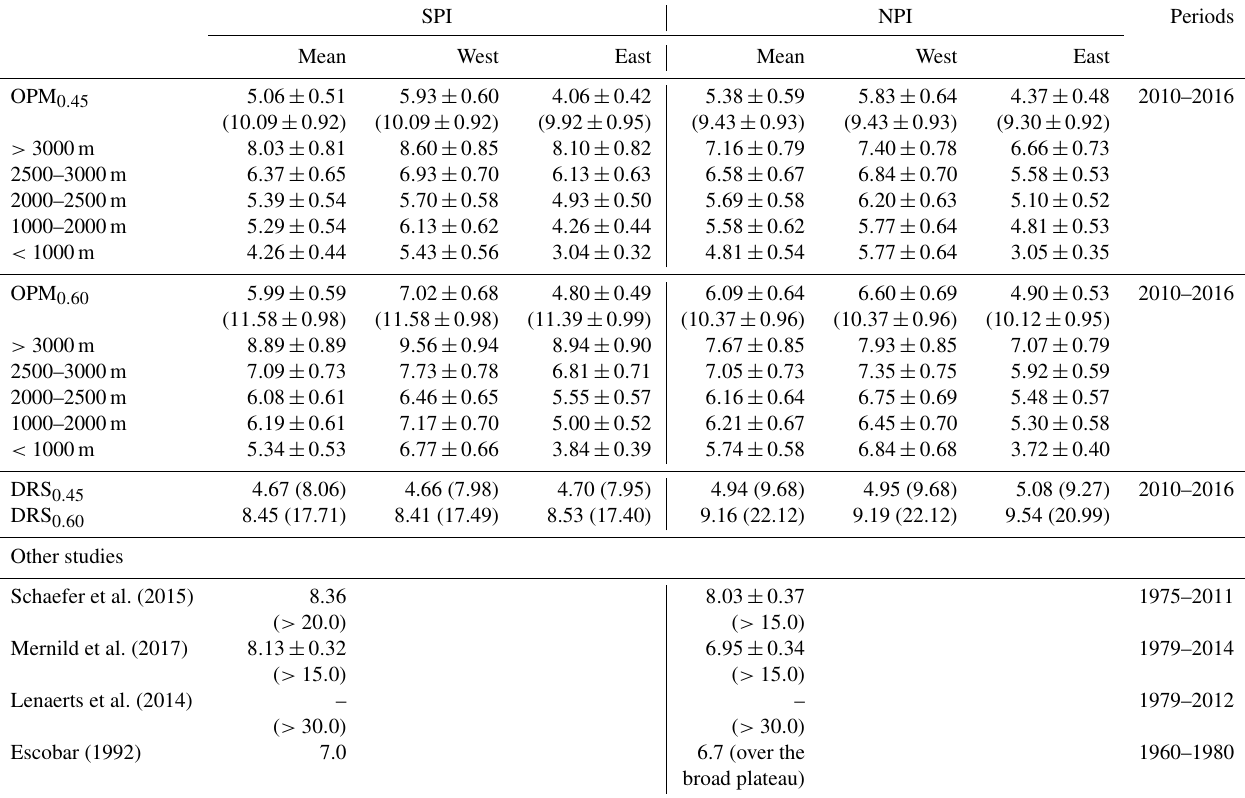
Table 1. Comparison of mean precipitation estimates on the SPI and NPI averaged over the entire icefield and the western (210–330 ◦ ) and eastern (30–150 ◦ ) slopes. Values are given in mw.e.yr − 1 . The local maximum values, if available, are shown in parentheses. OPM: linear orographic precipitation model. DRS: drying ratio